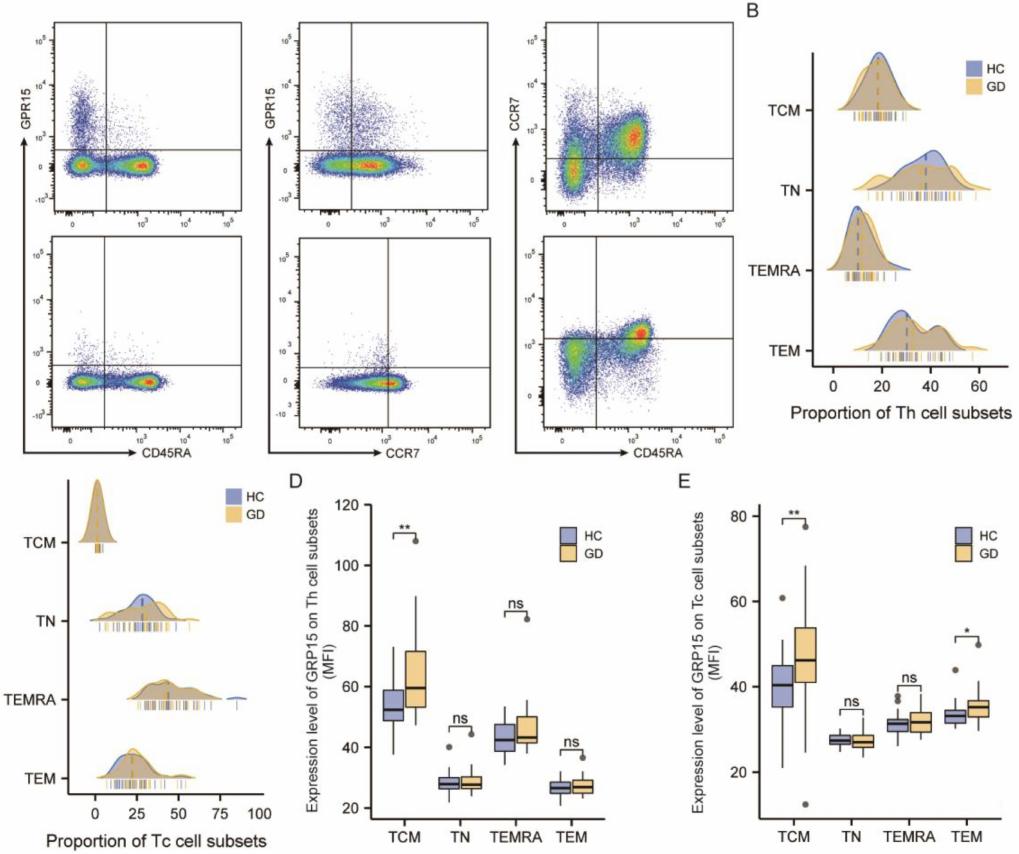
Figure 3. GPR15 expression was enhanced in several T-cell subsets of GD patients. ( A ) Typical flow cytometry plots and gating for subsets of T helper cells and cytotoxic T cells. ( B ) Proportions of T helper cells subsets in healthy controls and GD patients. ( C ) Proportions of cytotoxic T cells subsets in healthy controls and GD patients. ( D ) Statistical analysis of GPR15 MFI in subsets of T helper cells. ( E ) Statistical analysis of GPR15 MFI in subsets of cytotoxic T cells. (ns, p ≥ 0.05; *, p < 0.05; **, p < 0.01; HC: healthy controls, GD: Graves’